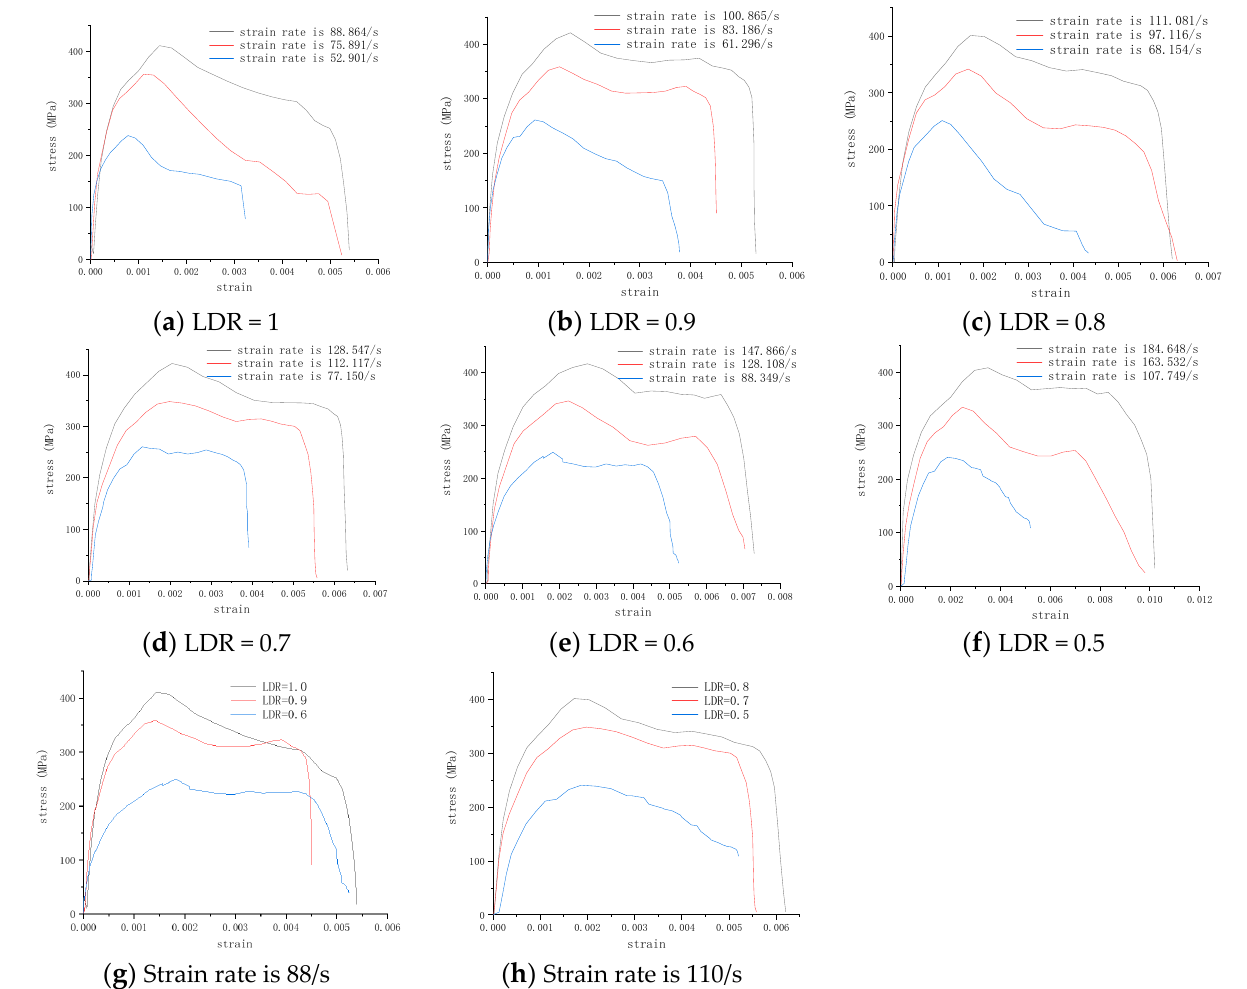
Figure 4. Stress–strain